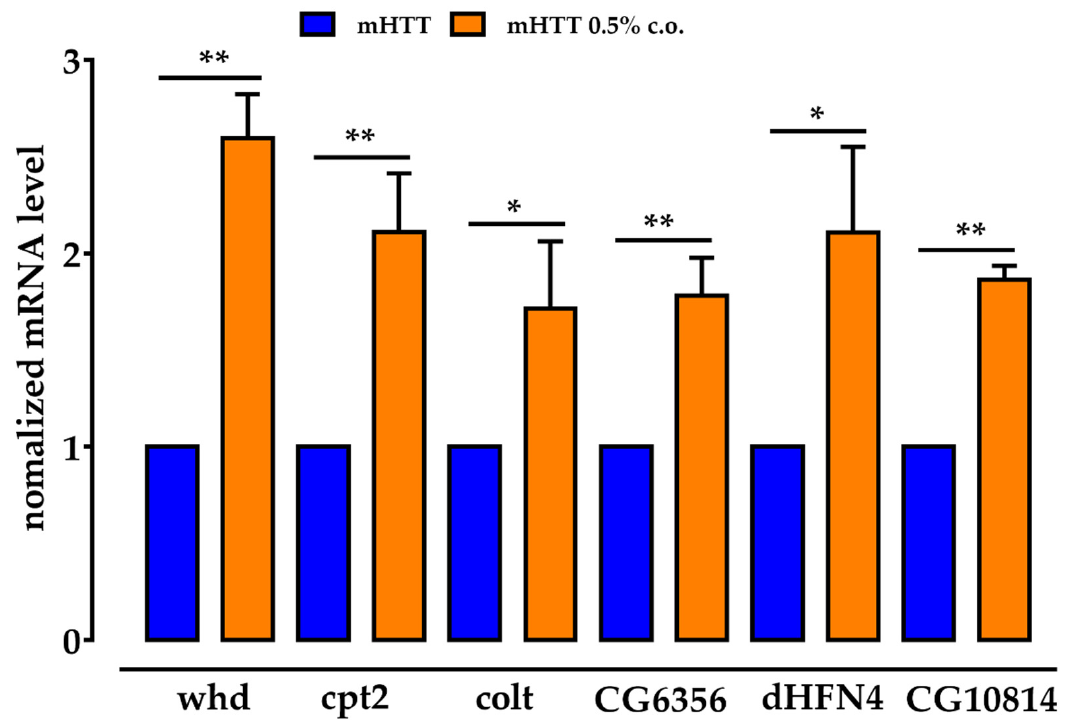
Figure 6. Dietary supplementation with coconut oil stimulates the expression of carnitine cycle genes in Drosophila. Administration of 0.5% coconut oil significantly overexpressed the key genes encoding for the components of the CS ( whd ; CPT2 and colt ) compared to untreated mHTT, as well as CG6356 , dHNF4, and CG10814. None of the examined gene showed significantly altered expression level in age-matched c.o. treated and untreated wt flies. Relative gene expression was calculated with respect to the rp49 gene and control samples. (q)RT-PCR was performed on three different experiments, and the results are expressed as the mean of the values obtained (mean ± SEM). Sidak’s one-way ANOVA pairwise multiple comparisons test was used to calculate significance. * p < 0.01; ** p < 0.001.